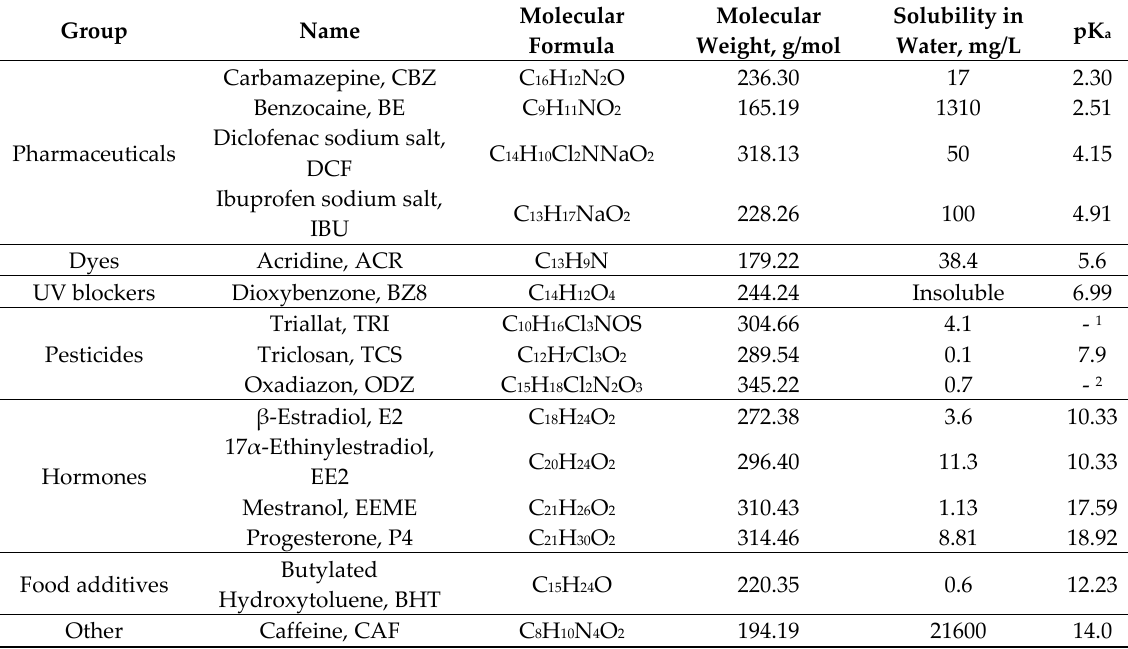
Table 1. Characteristics of the tested organic